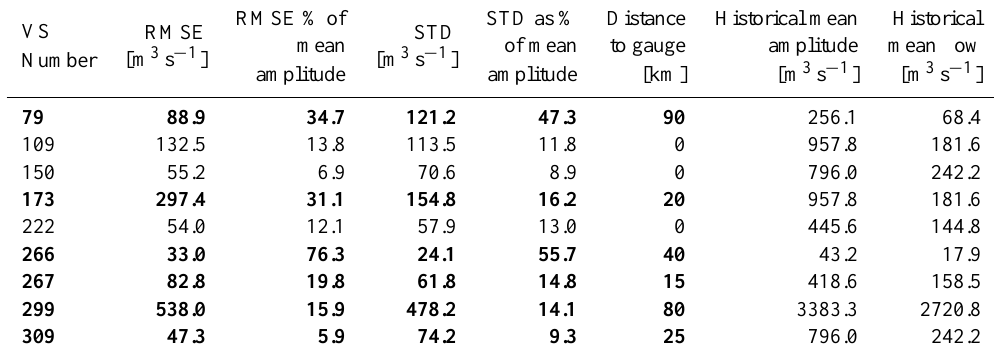
Table 5. Results for discharge calculations using method 3. Bold entries signal VS location not coinciding with that of the gauge used for comparison.